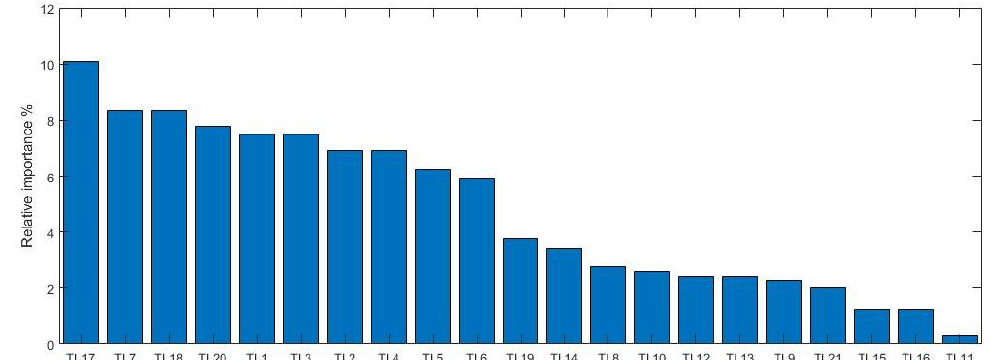
Figure 11. The ranking of the test loads after the last House of Noises. Given the method, the ranking yields a proportional scale: the importance of a successful test from a robustness point of view is proportional to the resultant